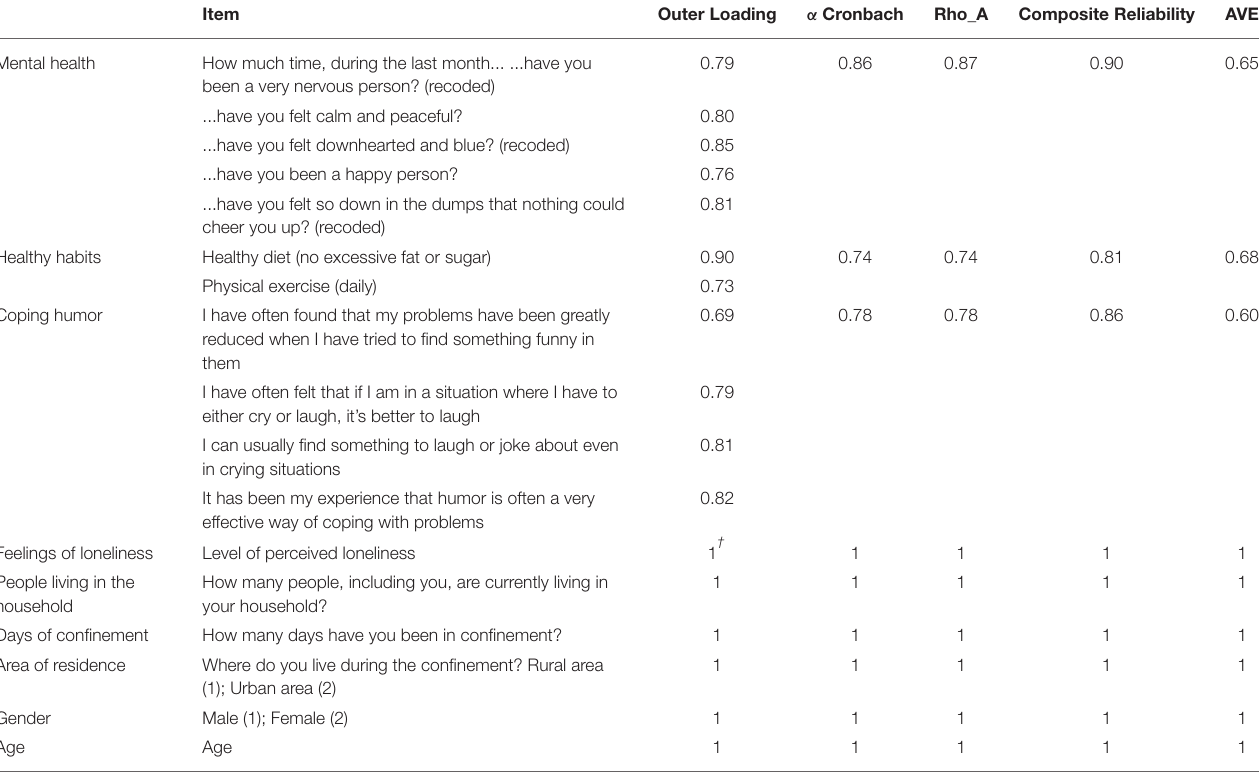
TABLE 1 | Evaluation of the assessment